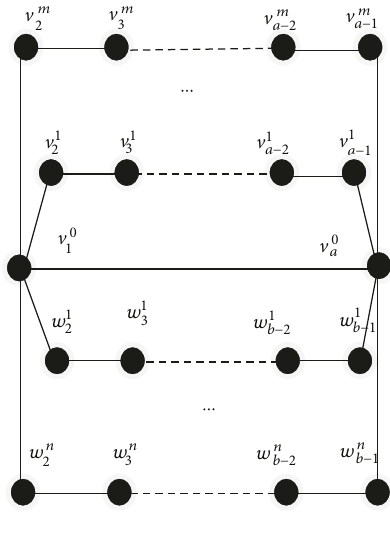
Figure 1: Graphs